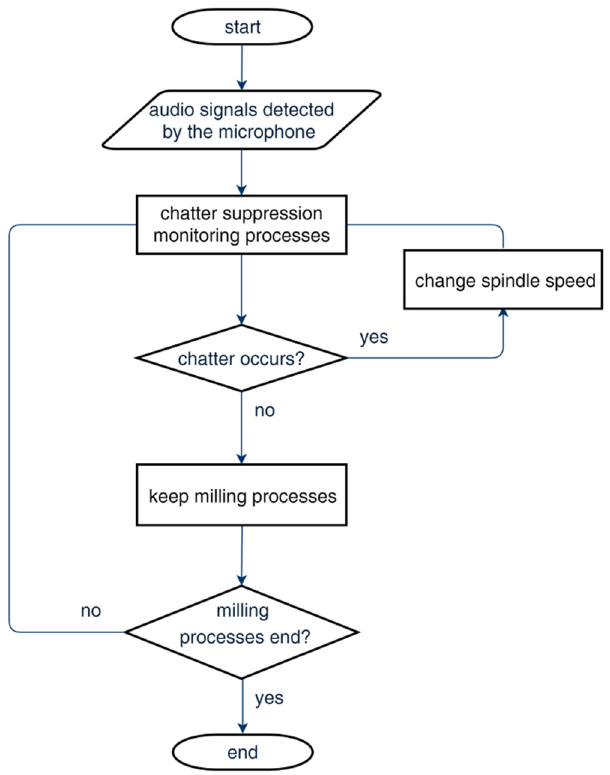
Figure 3. Flowchart of chatter suppression program.